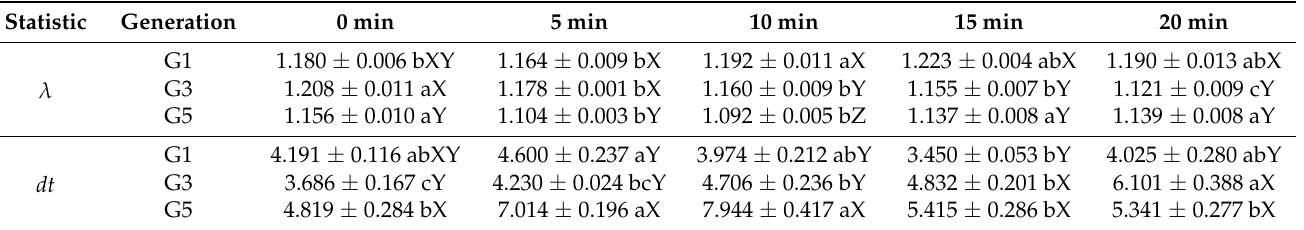
Table 1. λ and dt parameters of P. xylostella for each generation under HVEF at an intensity of 5.0 kV/cm for different